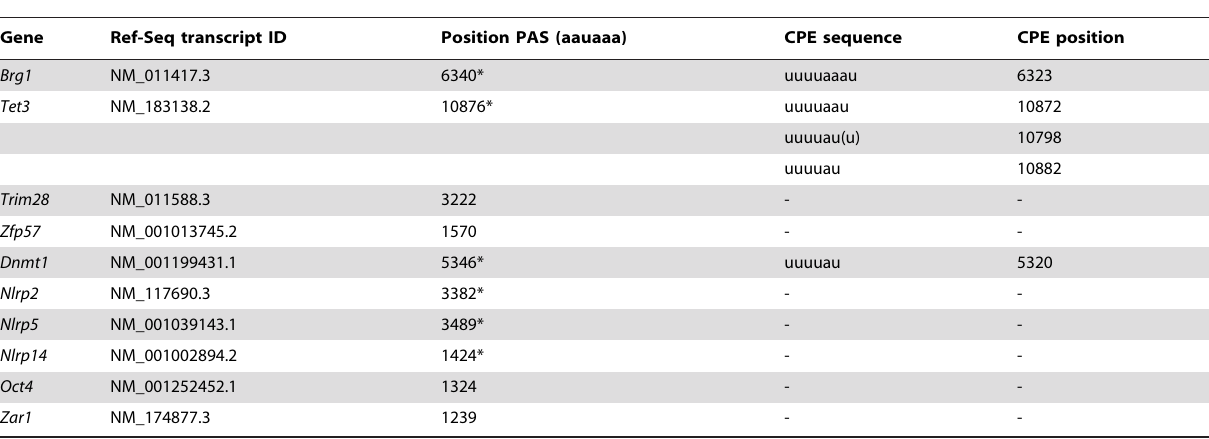
Table 2. Sequence and position of CPEs of ME-genes within 150 bp of the PAS.